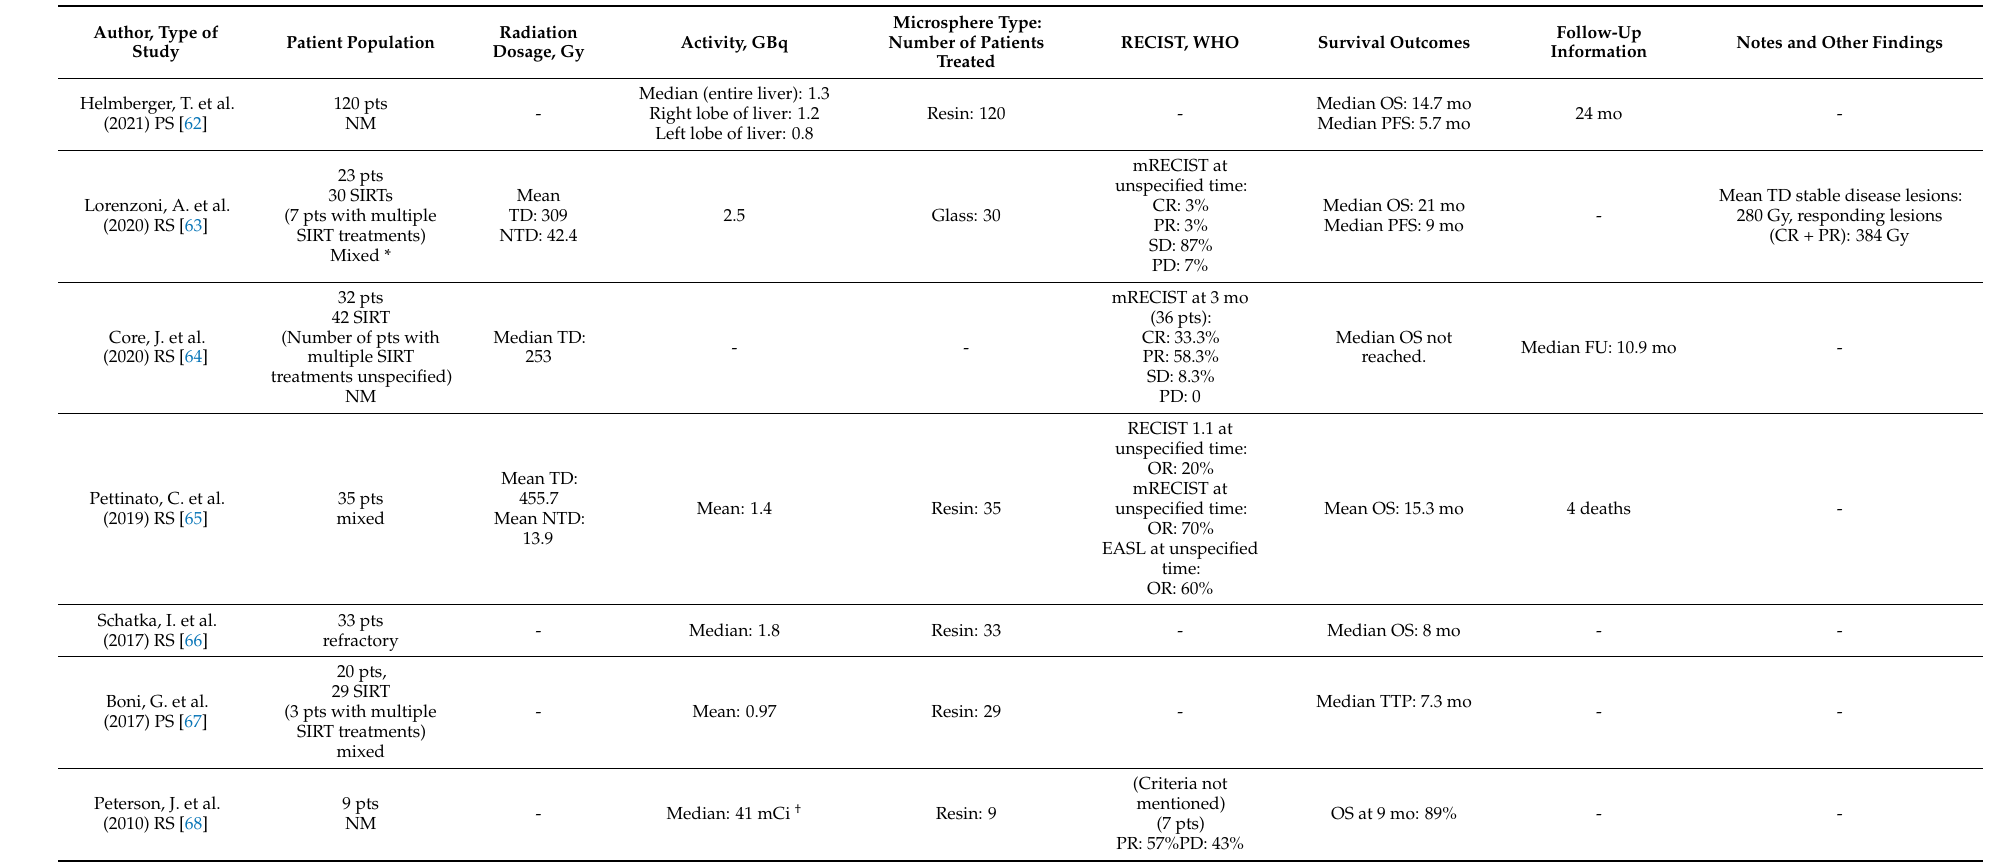
Table 2. Conference abstracts included in the